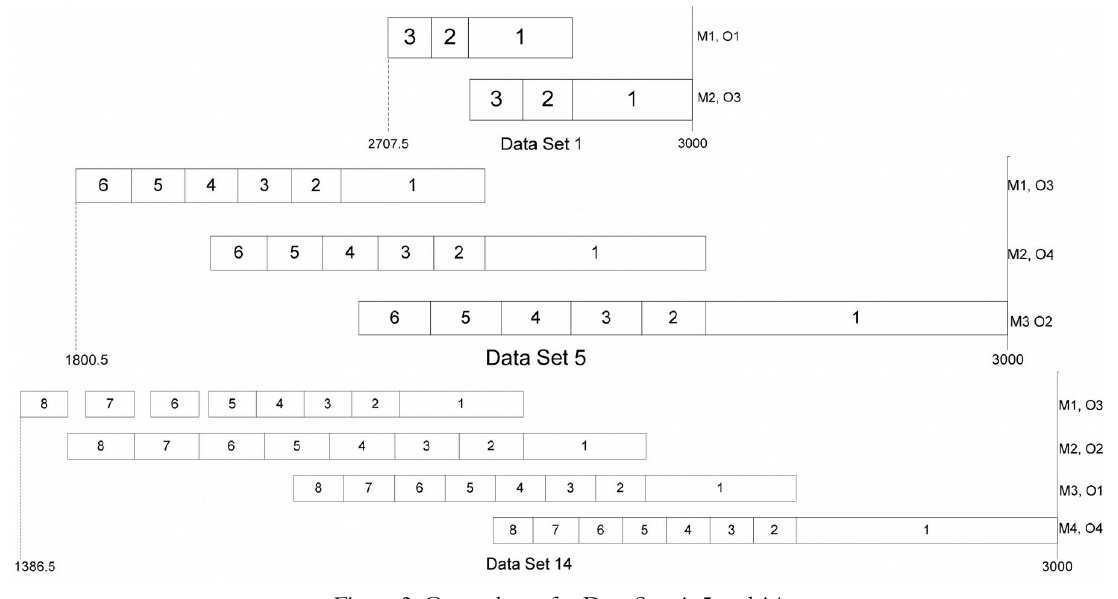
Figure 2. Gantt-charts for Data Sets 1, 5 and 14